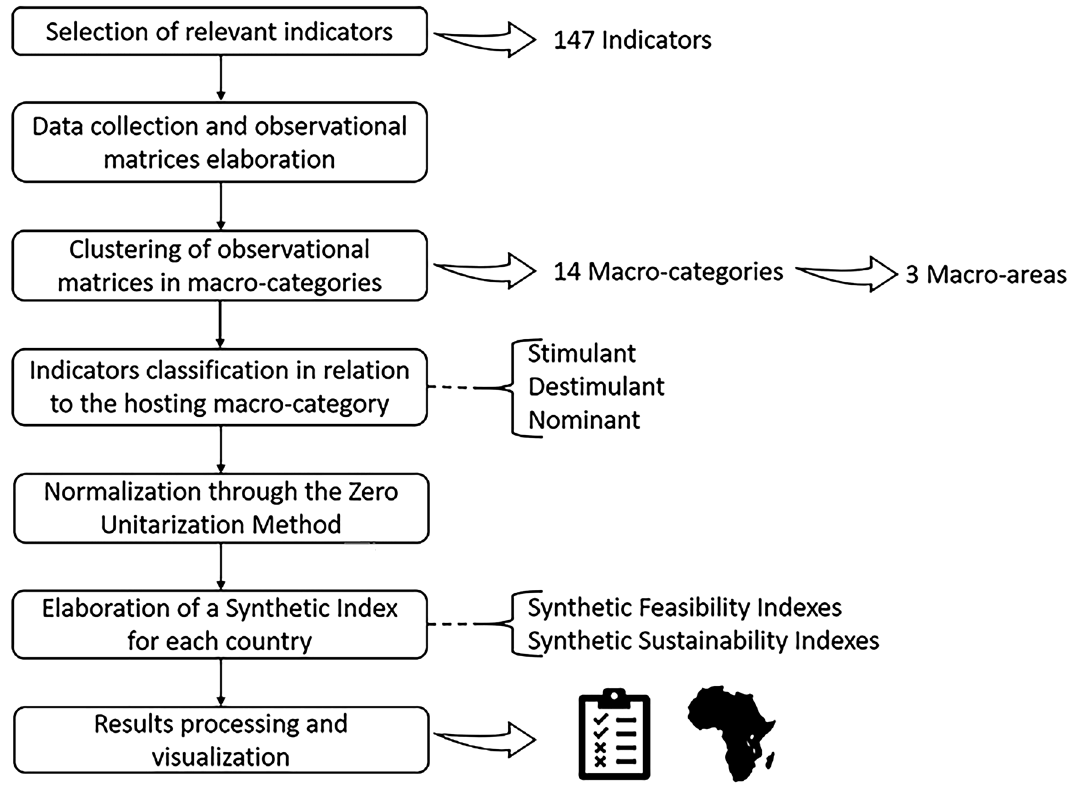
Figure 1. Methodological framework for the feasibility and sustainability assessment of vertical farming in